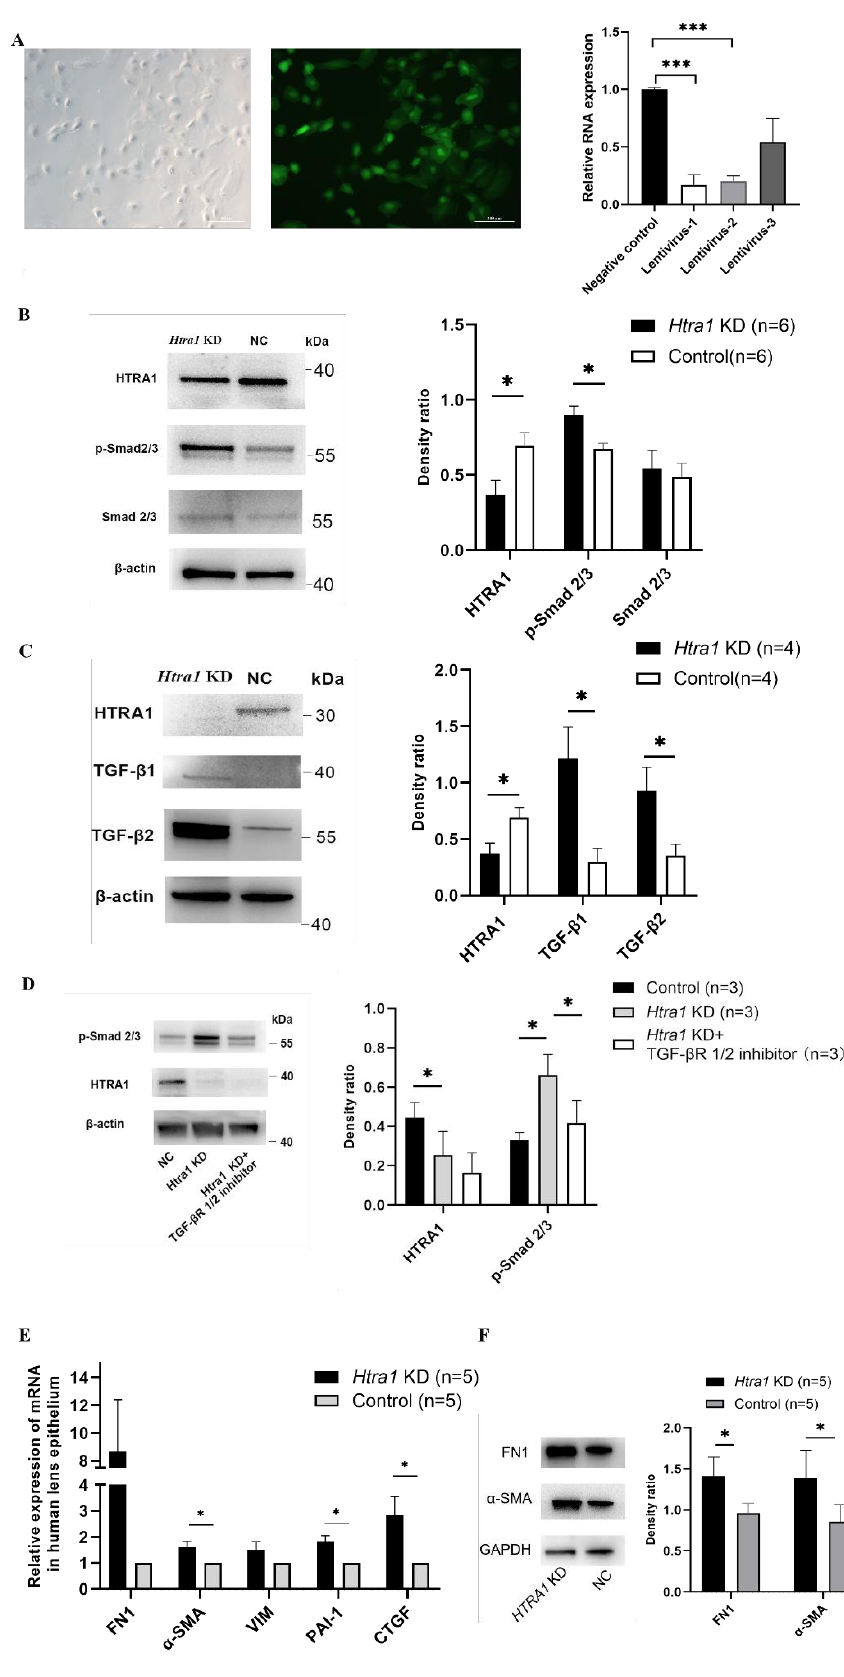
Figure 4. Downregulation of HTRA1 directly activated the TGF- β /Smad signalling in primary HLECs. ( A ) Primary HLECs after LV-HTRA1-RNAi lentivirus transfection, the middle image